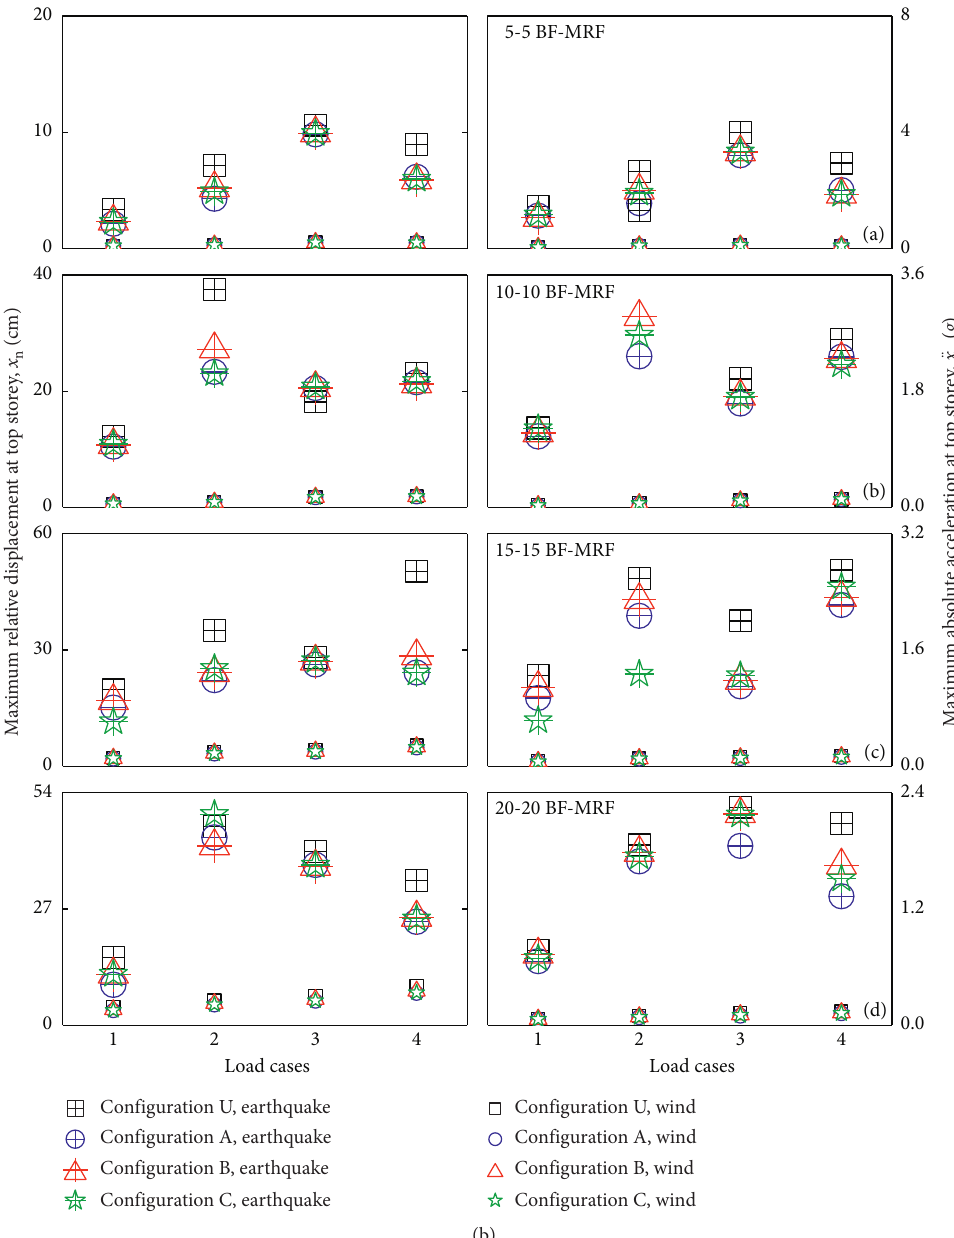
Figure 9: (a) Peak top floor displacement and acceleration responses of dissimilar connected MRF-BF buildings for equal storey height under historical earthquake ground motions and simulated wind forces. (b) Peak top floor displacement and acceleration responses of dissimilar connected BF-MRF buildings for equal storey height under historical earthquake ground motions and simulated wind